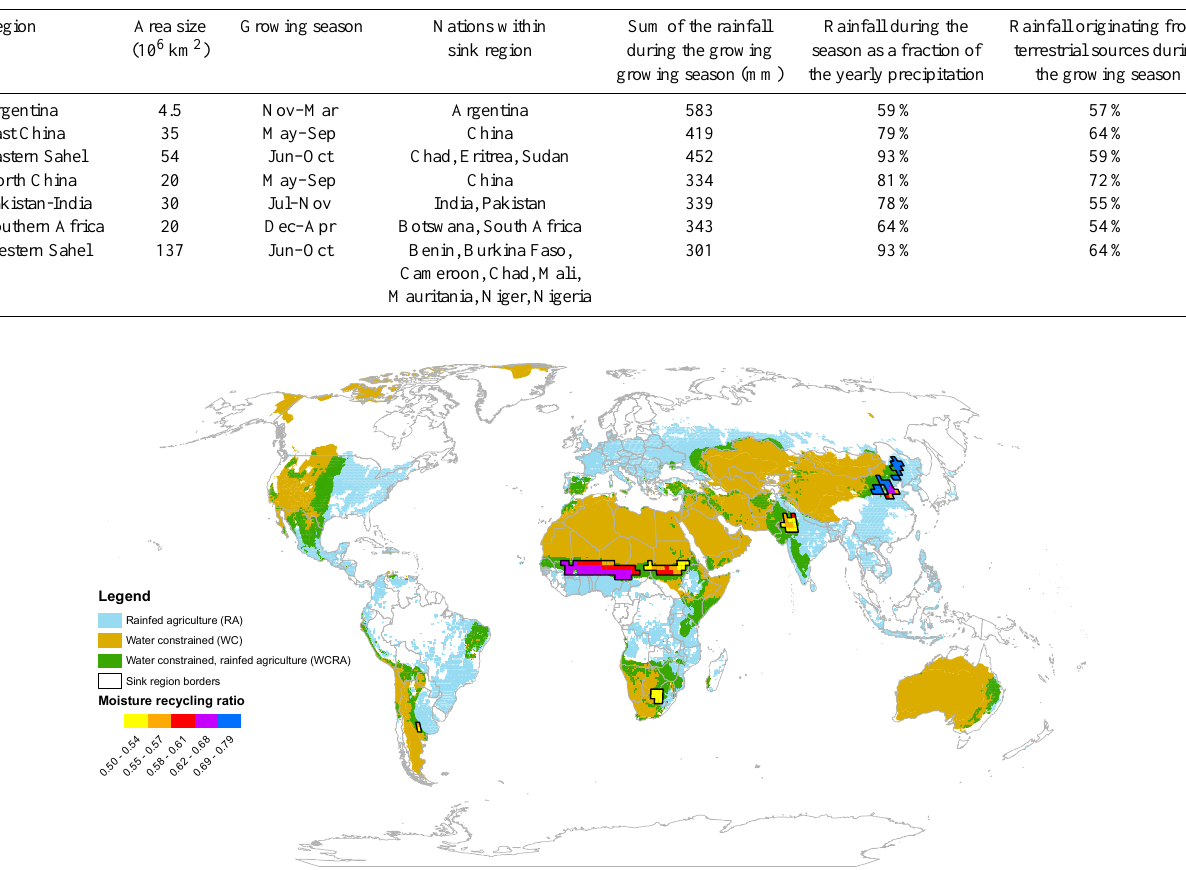
Table 1. Characteristics of the recycling dependent water constrained rainfed agricultural regions (sink regions). The three staple crops used in this analysis (maize, millet, and sorghum) were grown in all seven of the sink regions. Evaporation and precipitation data were taken from the ERA-Interim archive.